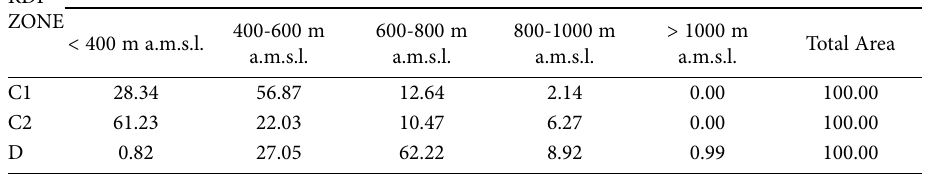
Distribution of farmland area in the sample (%) by REGIONAL DEVELOPMENT PROGRAMME (RDP) ZONE inside each ALTITUDE CLASS ZONE